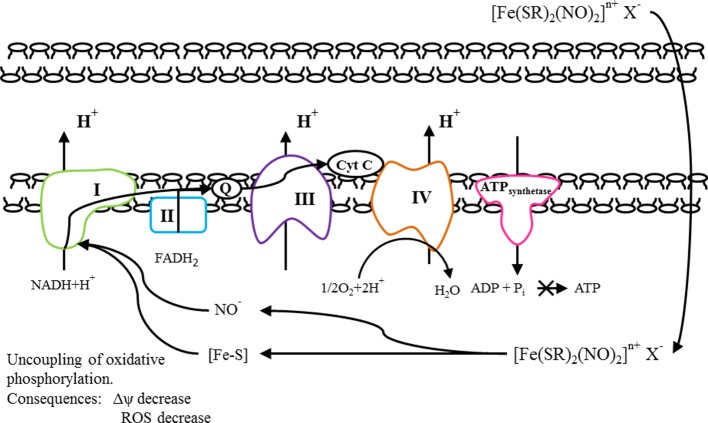
The proposed mechanism of action of DNICs.